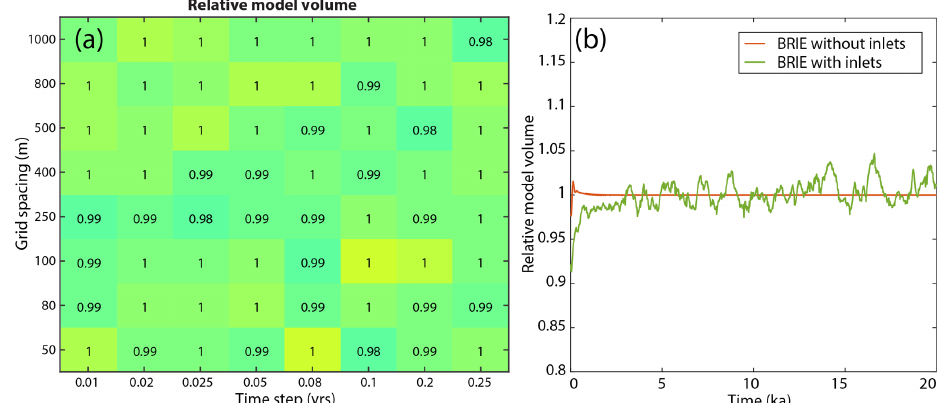
Figure 7. Model volume (barrier volume and offshore deposits) relative to the analytically determined model volume for (a) averaged for different time steps and alongshore grid lengths, as well as (b) through time, showing mass